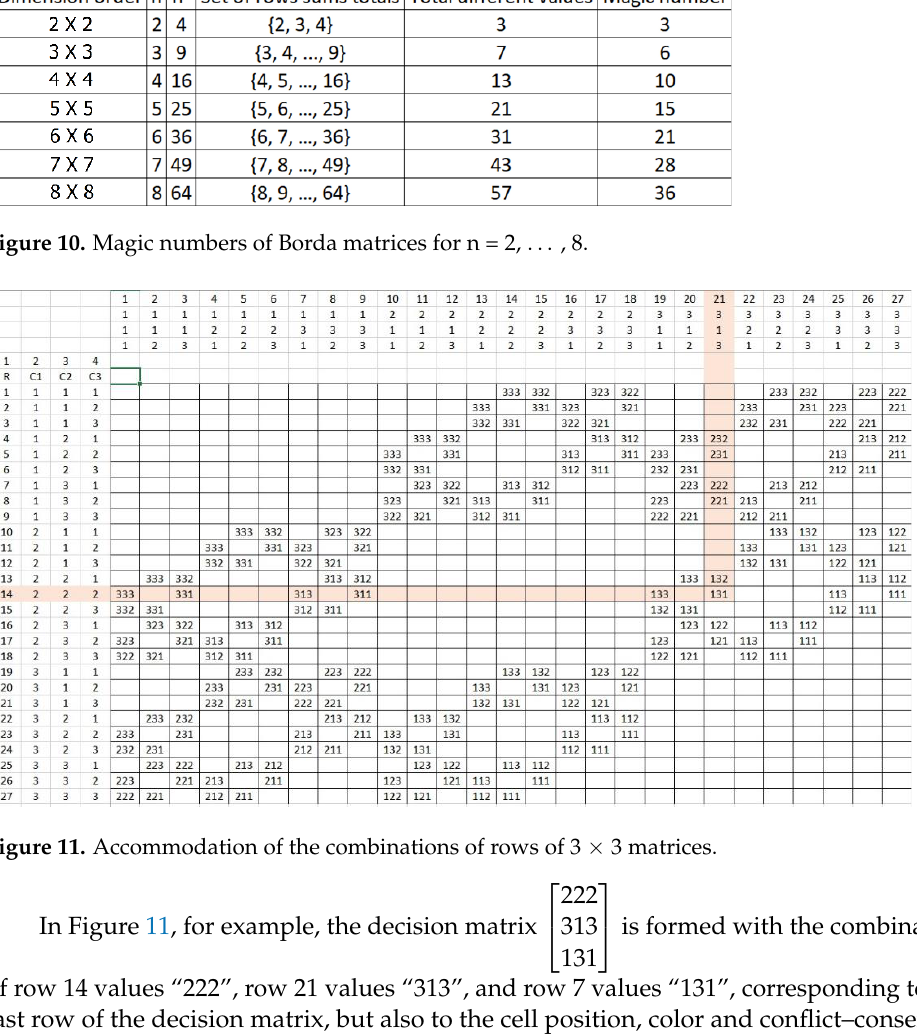
Figure 11. Accommodation of the combinations of rows of 3 × 3 matrices.